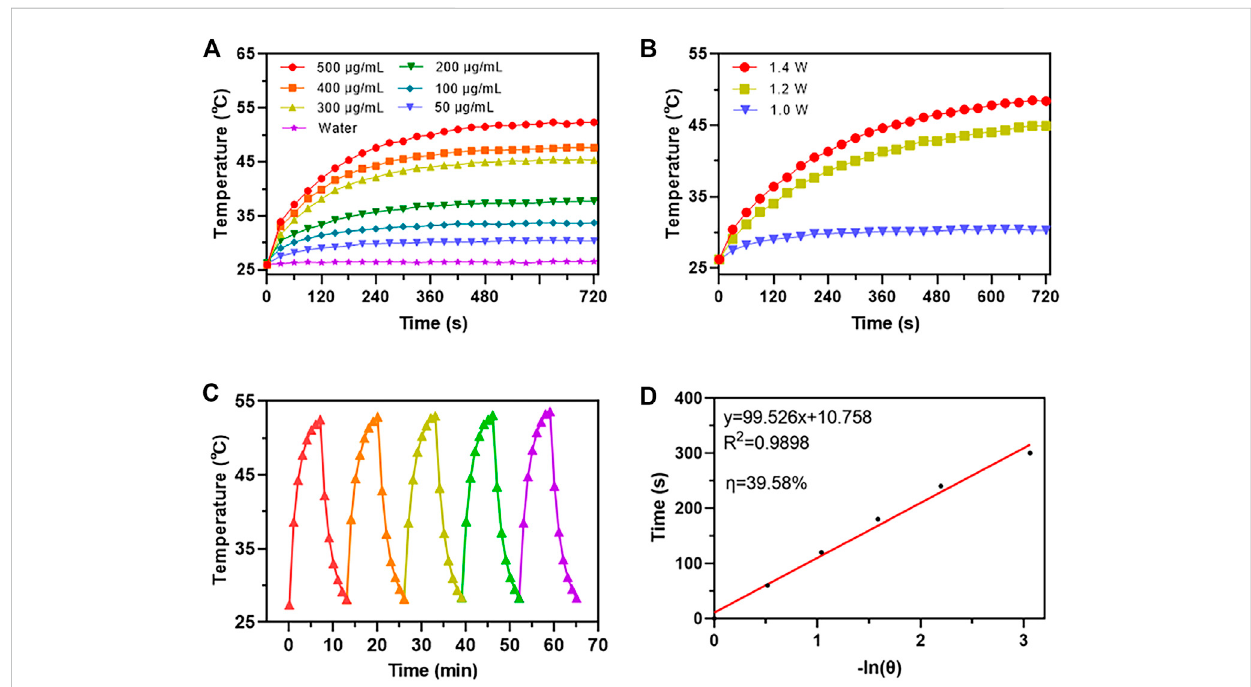
FIGURE 2 Photothermal performance analysis of AuNC@Fe 3 O 4 . (A) Temperature change curves of water and AuNC@Fe 3 O 4 aqueous solution after different treatments (B) Temperature change curves of AuNC@Fe 3 O 4 after different treatments (C) Photostability of AuNC@Fe 3 O 4 solution under irradiation for fi ve cycles. (D) Time versus -ln( θ ) plot of the AuNC@Fe 3 O 4 solution.